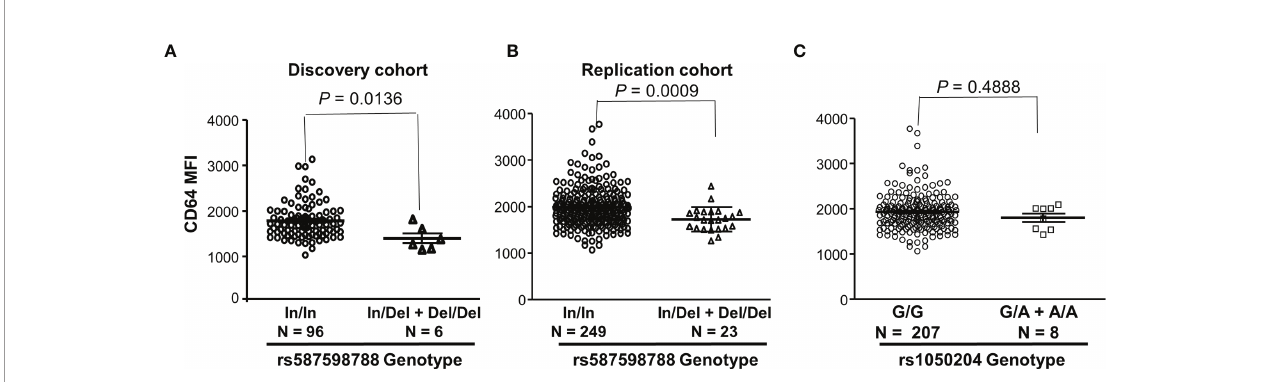
FIGURE 3 | FCGR1A genotypes containing the rs587598788-c.845-17delTCTTTG (rs587598788Del) allele are signi fi cantly associated with low CD64 expressions. (A) Monocytes from rs587598788-c.845-23 (rs587598788In) homozygous donors (In/In) expressed signi fi cantly higher levels of CD64 than those from the combined rs587598788 heterozygous (In/Del) and rs587598788Del homozygous (Del/Del) donors (Mann-Whitney test P = 0.0136). (B) CD64 expression data from a replication cohort con fi rmed that rs587598788-In/In homozygous donors expressed signi fi cantly higher levels of CD64 than those from the combined rs587598788- In/Del heterozygous and Del/Del homozygous donors. (C) CD64 expression levels on monocytes were not signi fi cantly different between the SNV rs1050204-G/G homozygous donors (G/G, N = 207) and the combined rs1050204-G/A heterozygous and rs1050204-A/A homozygous donors (Mann-Whitney test P = 0.488).